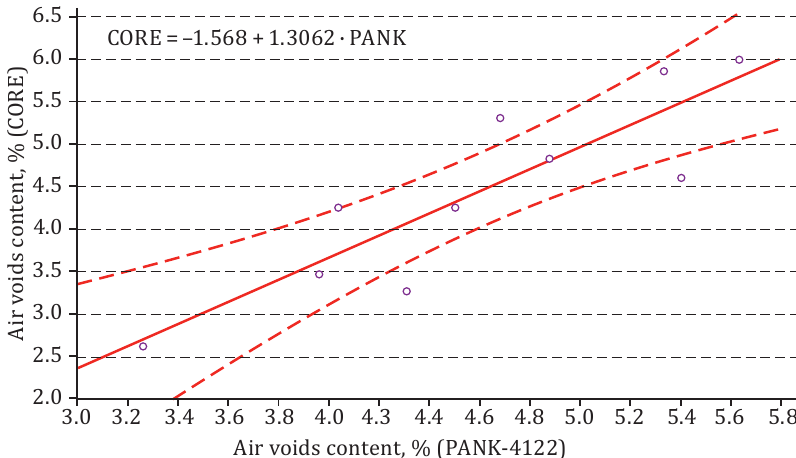
Figure 6. Correlation between the core results and the GPR air void content of road section No.